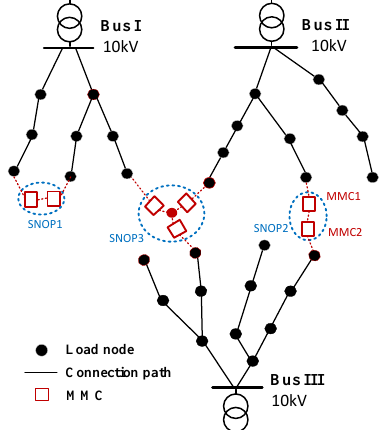
Figure 1. System connection form of SNOP.